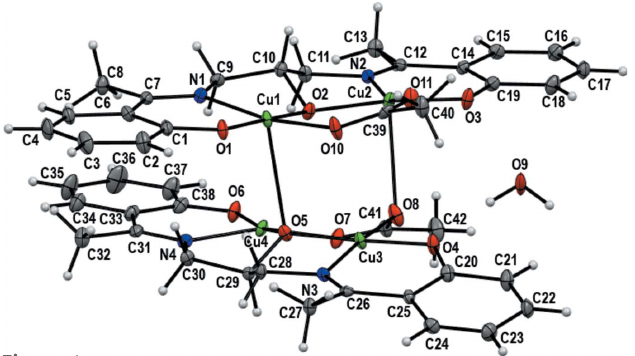
Figure 1 A view of the title compound, showing the atom-numbering scheme.